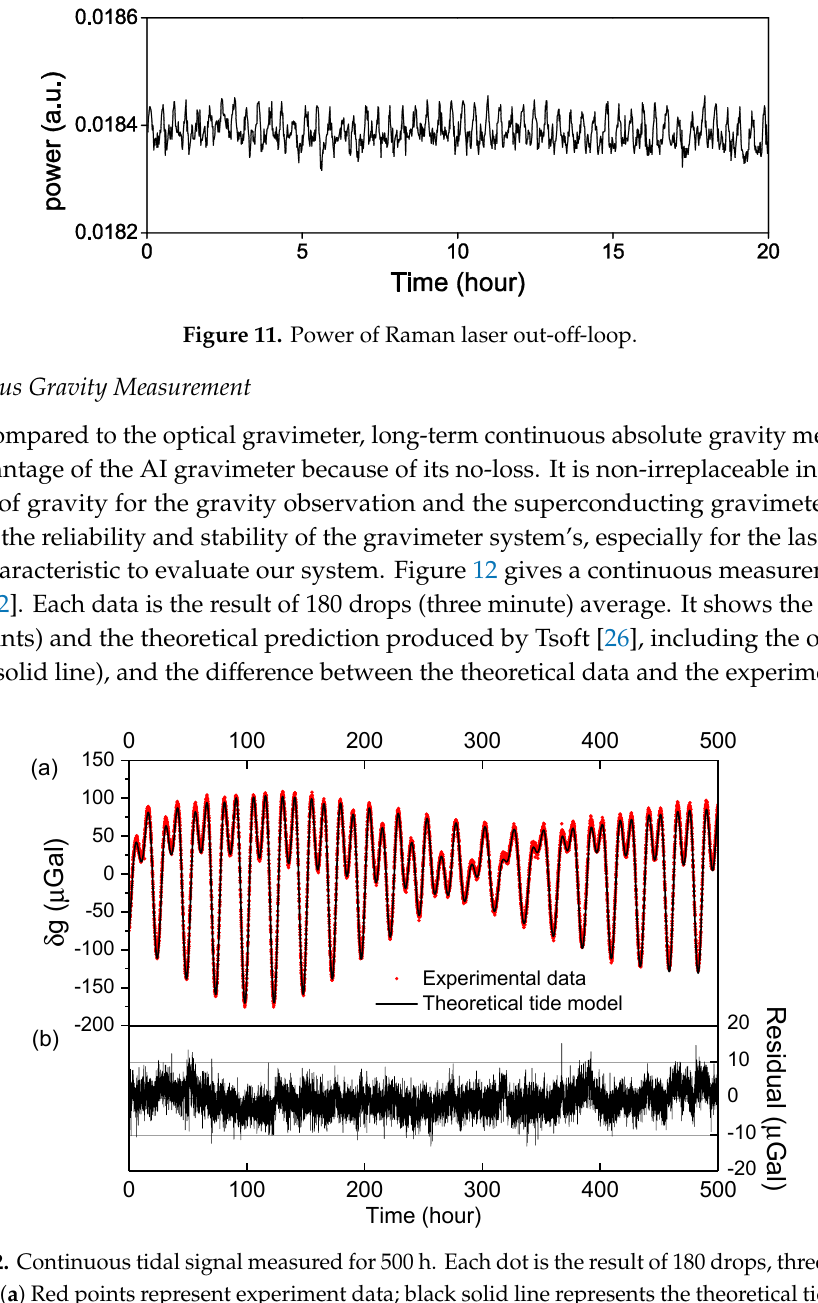
Figure 10. Power both of the Raman laser in free running (upper) and in stabilization (lower).